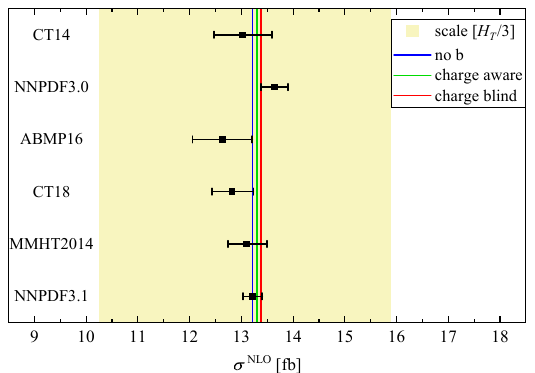
Figure 10 . NLO integrated fiducial cross section for the pp → e + ν e µ − ¯ ν µ b ¯ b b ¯ b + X production √ process at the LHC with s = 13 TeV for µ 0 = H T / 3 . Theoretical results with and without the initial state b -quark contributions are provided for the NLO NNPDF3.1 PDF set. Also given are results with other PDF sets for the case with no initial state bottom-quark